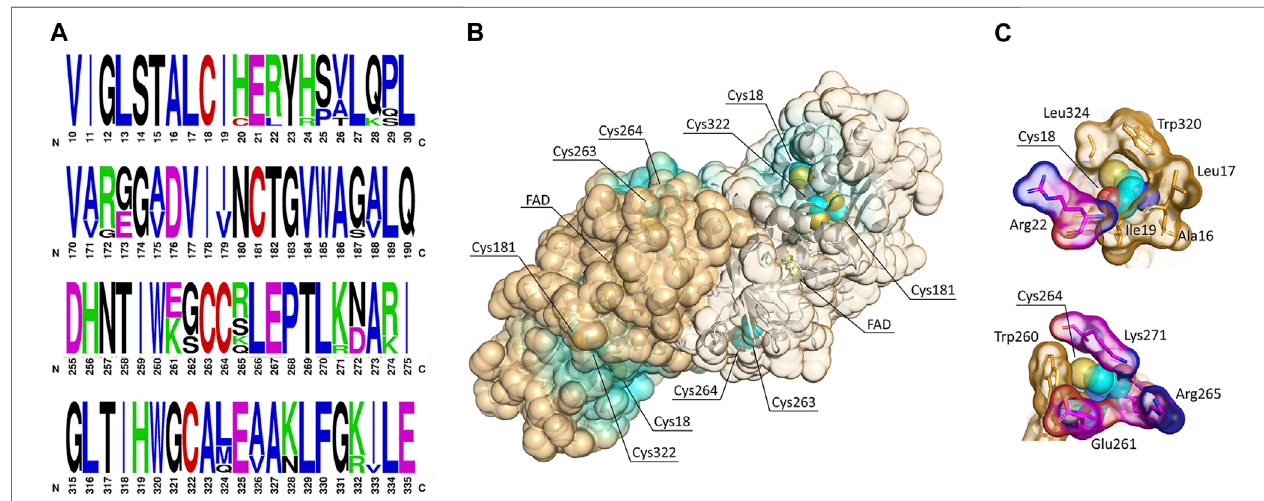
FIGURE 1 | Cysteine residues in hDAAO. (A) Weblogo representation of conserved residues identi fi ed by the alignment of DAAO sequences from Homo sapiens, Mus musculus, Rattus norvegicus, Sus scrofa, Bos taurus, Cavia porcellus, and Macaca fascicularis . The x -axis represents amino acid positions (the annotated numbering refers to the human enzyme). The height of symbols is proportional to the degree of conservation of single residues. Panels represent sequence stretches of 20 residues containing cysteine residues, shown in red. Five cysteine residues appear highly conserved in mammalian DAAOs. Figure prepared using WebLogo (https://weblogo.berkeley.edu/logo.cgi). (B) Solvent-accessible surface (SAS) as calculated for the hDAAO dimer (pdb code 2E49). Cysteine residues are represented as sphere (carbon atoms in cyan, sulfur atoms in yellow), the FAD cofactor is represented as sticks (yellow), and the backbone is shown as cartoon. Protein surface is coloredbyproximityofcysteineresidues(cyan (cid:2) cysteineresidueslocatedwithin5 Åfromthesurface;orange (cid:2) cysteineresidueslocatedatadistancehigherthan15 Å from the surface).SAS has been calculated based on asolvent radius of 1.4 Å. Two ofthe conserved cysteineresidues are likely accessible tomodi fi cations. (C) Details showing the amino acidic environment of selected cysteine residues, represented as spheres (carbon atoms in cyan, sulfur atoms in yellow, nitrogen atoms in blue, and oxygen atoms in red). The surrounding residues are depicted as sticks; the van der Waals surface is shown. Hydrophobic residues are colored in orange, while charged residues are colored by element (carbon atoms in magenta, nitrogen atoms in blue, and oxygen atoms in red). Illustrations prepared with “ The Protein Imager online molecular viewer ”